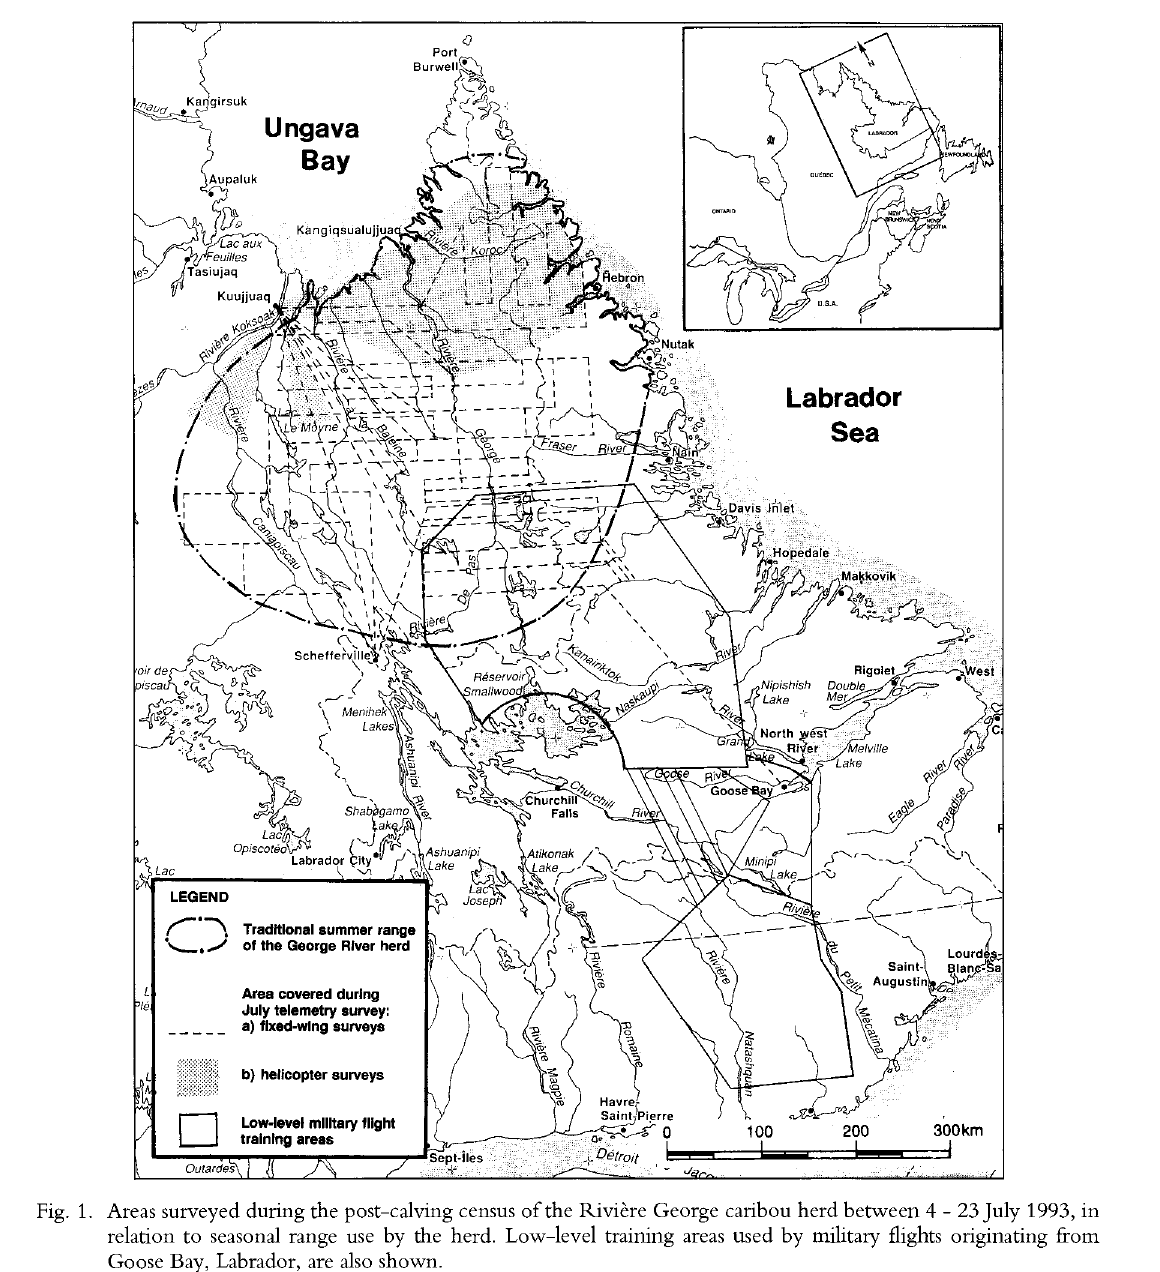
Fig. 1. Areas surveyed during the post-calving census of the Rivière George caribou herd between 4 - 23 July 1993, in relation to seasonal range use by the herd. Low-level training areas used by military flights originating from Goose Bay, Labrador, are also